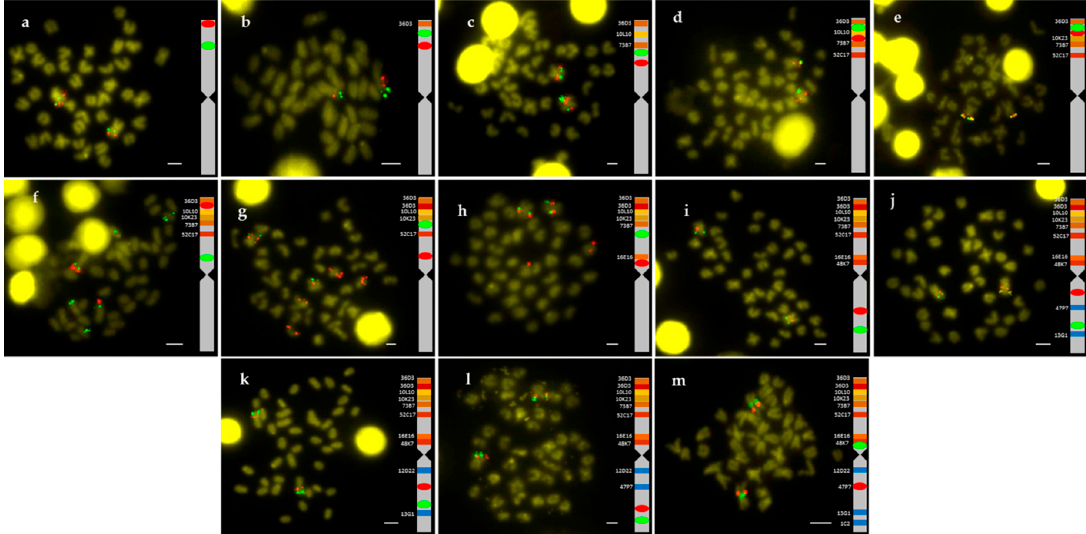
Figure 1. Double FISH-BAC of ( a ) 73B7 (green)/36D3 (red), ( b ) 10L10 (green)/73B7 (red), ( c ) 10K23 (green)/52C17 (red), ( d ) 5K5 (green)/10K23 (red), ( e ) 5K5 (green)/10L10 (red), ( f ) 16E16 (green)/5K5 (red), ( g ) 73B7 (green)/16E16 (red), ( h ) 52C17 (green)/48K7 (red), ( i ) 13G1 (green)/47P7 (red), ( j ) 1C2 (green)/12D22 (red), ( k ) 1C2 (green/47P7 (red), ( l ) 1C2 (green)/13G1 (red), and ( m ) 53B20 (green)/47P7 (red). Bar = 2 µm.